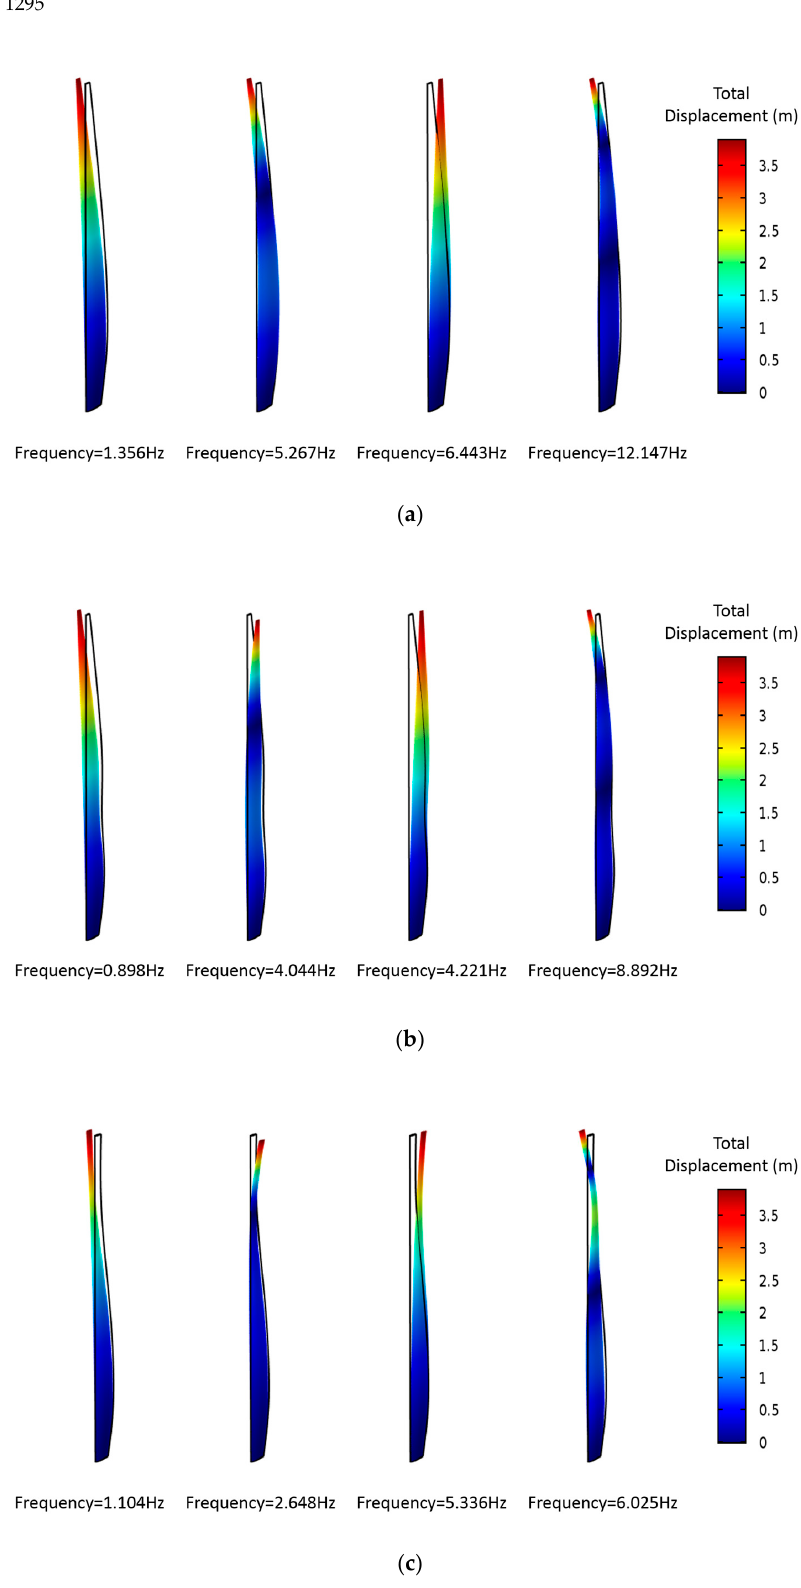
Figure 9. The shapes of first four modes for ( a ) original length blade; ( b ) blade-extension of 20% at the tip; ( c ) blade extension of 20% in the